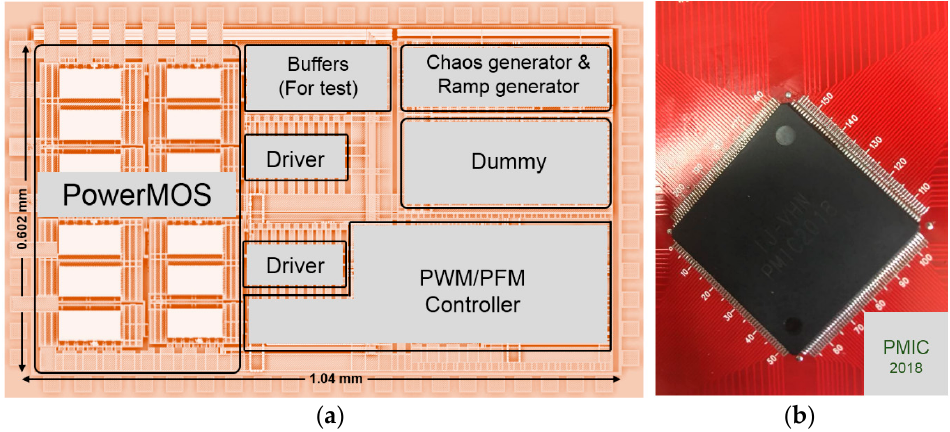
Figure 14. ( a ) Chip layout of the chaotic-PWM (pulse-width modulation) voltage-mode buck converter; ( b ) Chip microphotograph; chip test on printed circuit board (PCB) (the top).